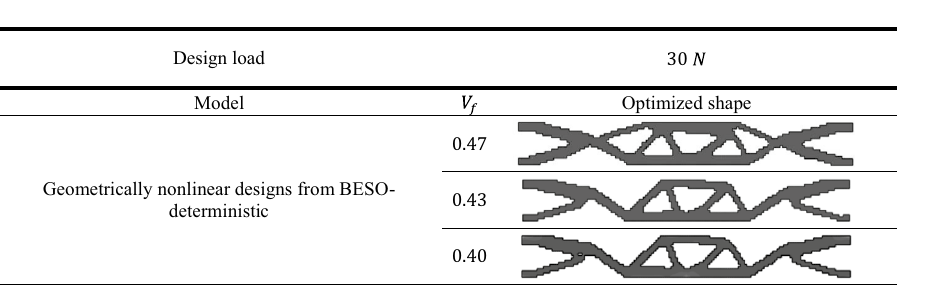
Table 2. The optimal solution of deterministic geometrically nonlinear design of the